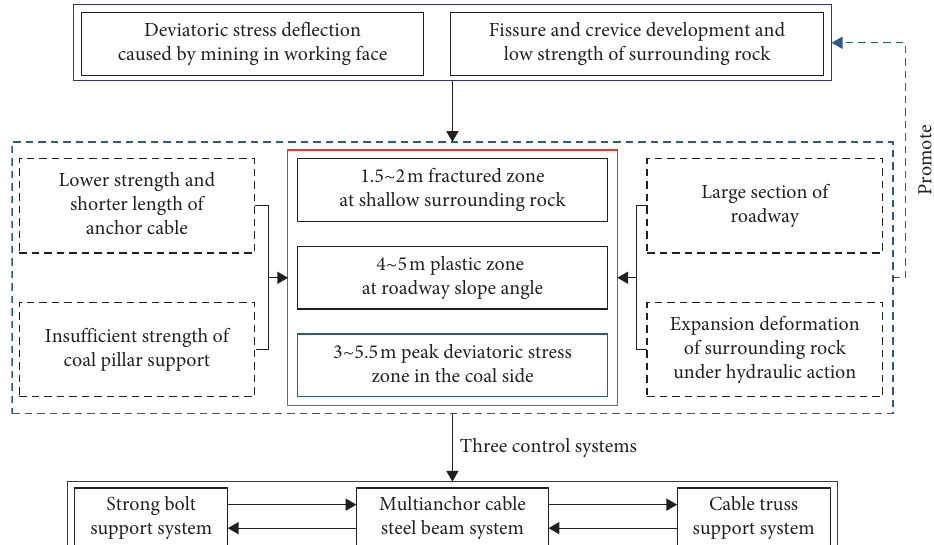
Figure 12: Roadway instability mechanism and control system.